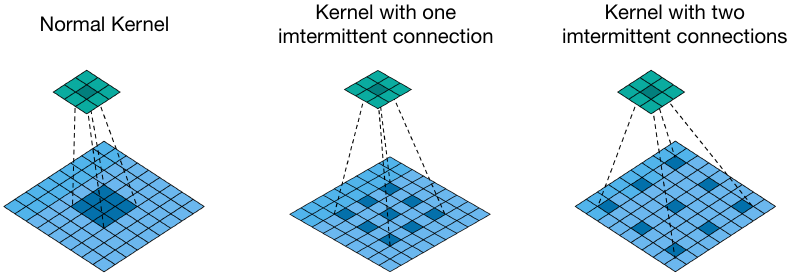
Figure 6. The normal convolutional kernel and dilation convolutional kernels.